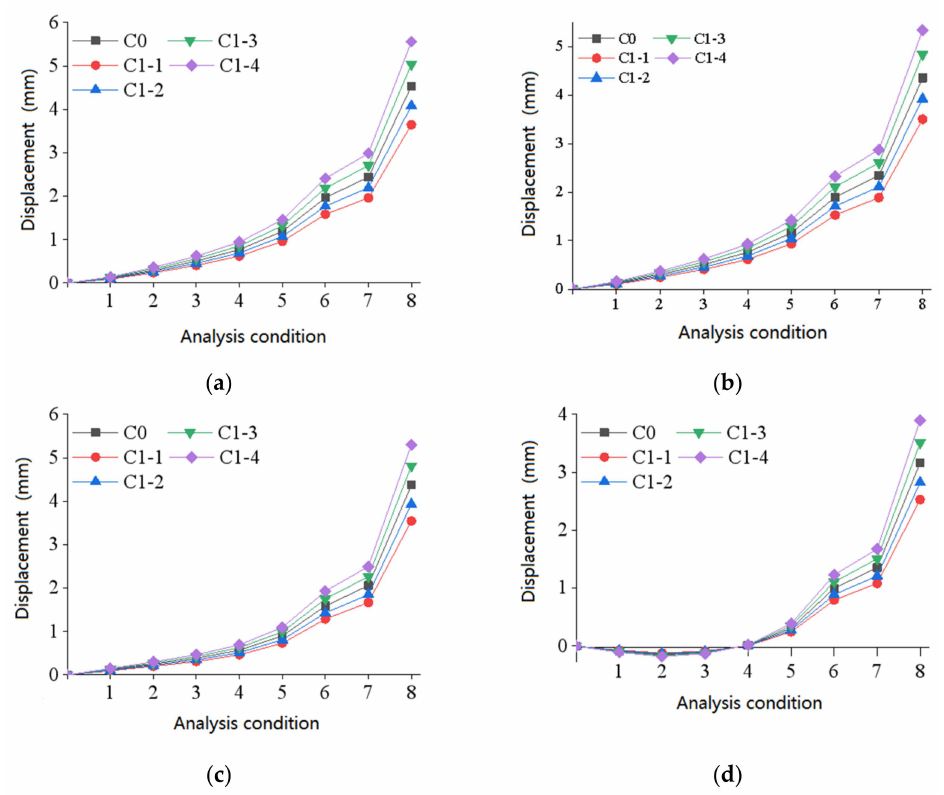
Figure 7. Model C1/C0 displacement analysis results (mm): ( a ) W2 displacement change; ( b ) W3 displacement change; ( c ) W4 displacement change; ( d ) W5 displacement change.